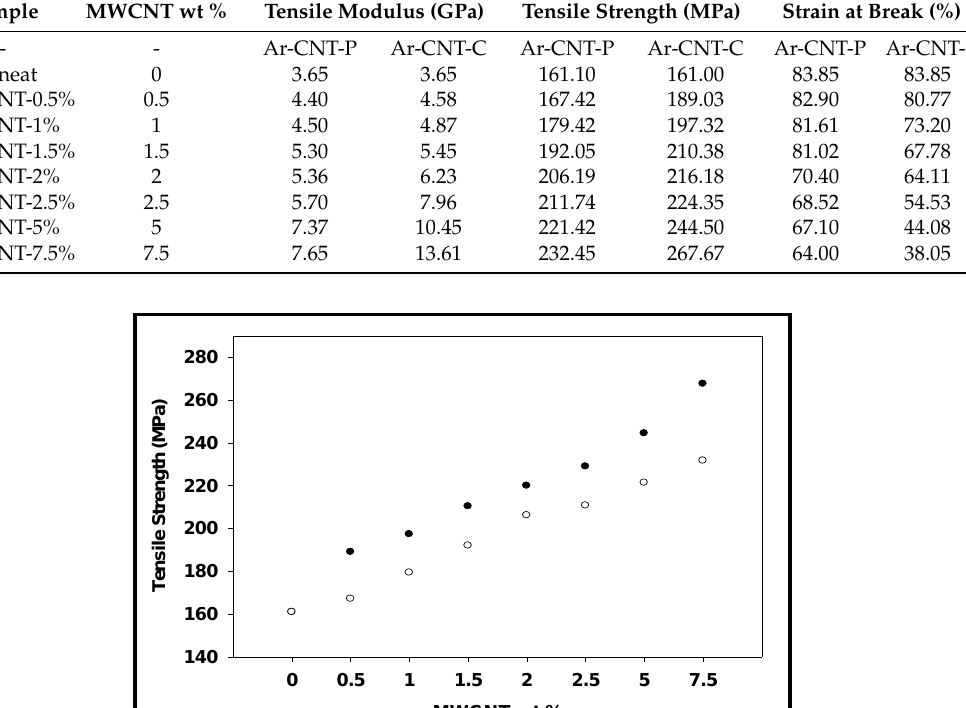
Figure 10. Tensile strength variation with CNT loading in Ar-CNT-P ( ○ ) and Ar-CNT-C (●) composites.